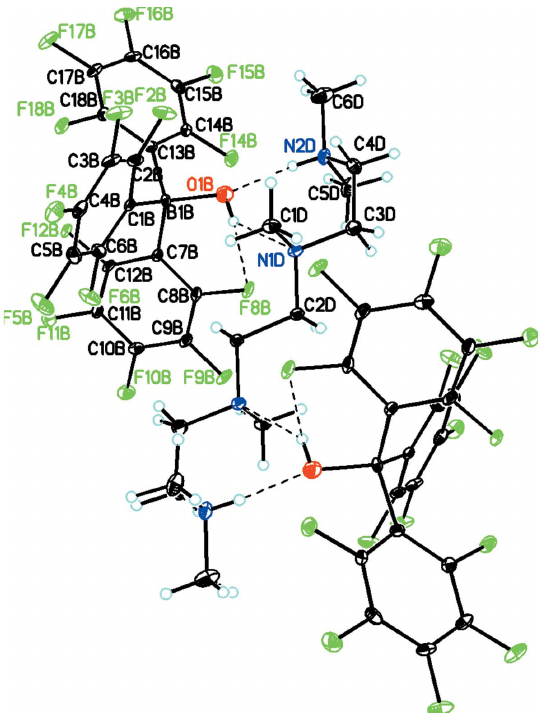
Figure 2 Diagram showing the structure of the [C 12 H 32 N 4 ] 2+ dication ( D ) and two [C 18 HBF 15 O] + anions ( B ). Only symmetry-independent atoms are labelled. Benzene solvate molecules are omitted for clarity. Hydrogen bonds are shown with dashed lines. Atomic displacement parameters are at the 30% probability level.